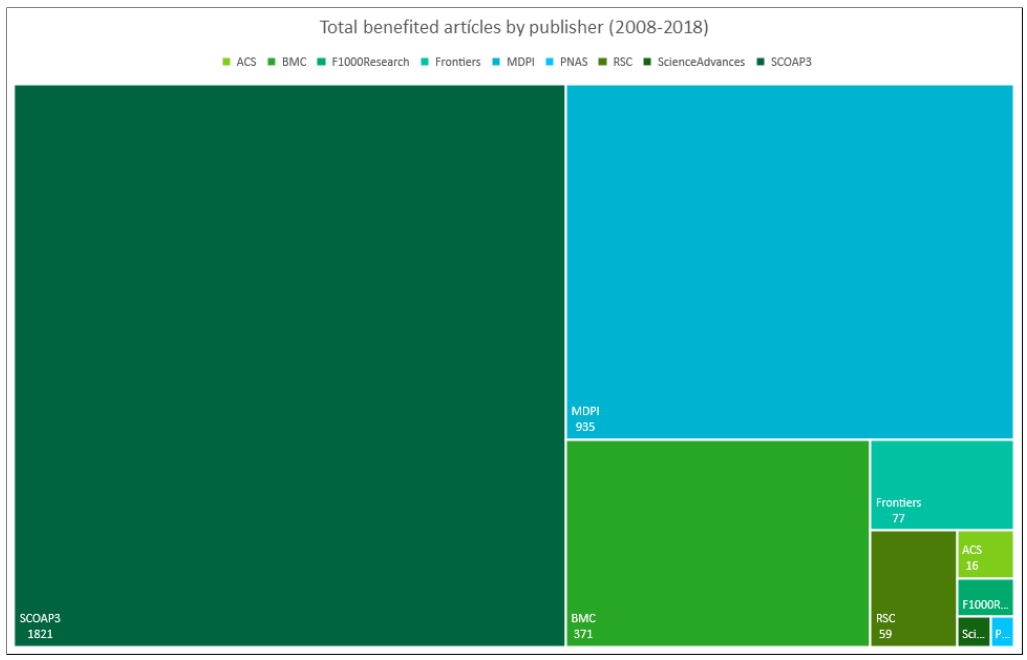
Figure 4. Total CSIC Articles by Publisher (2008–2018) that have benefitted from institutional Programme.